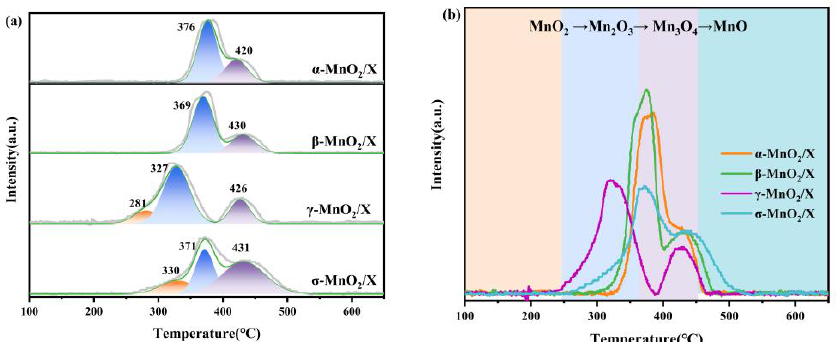
Figure 4. ( a ) H 2 -TPR profiles and ( b ) related peaks analysis of α -MnO 2 /X, β -MnO 2 /X, γ -MnO 2 /X, and σ -MnO 2 /X